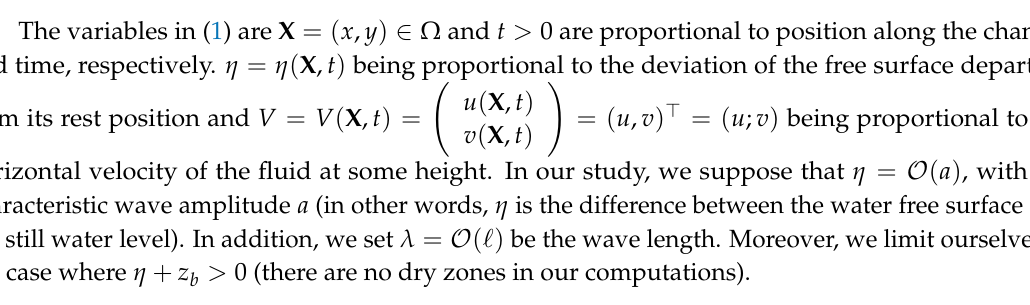
Figure 1. The sketch of the physical domain Ω